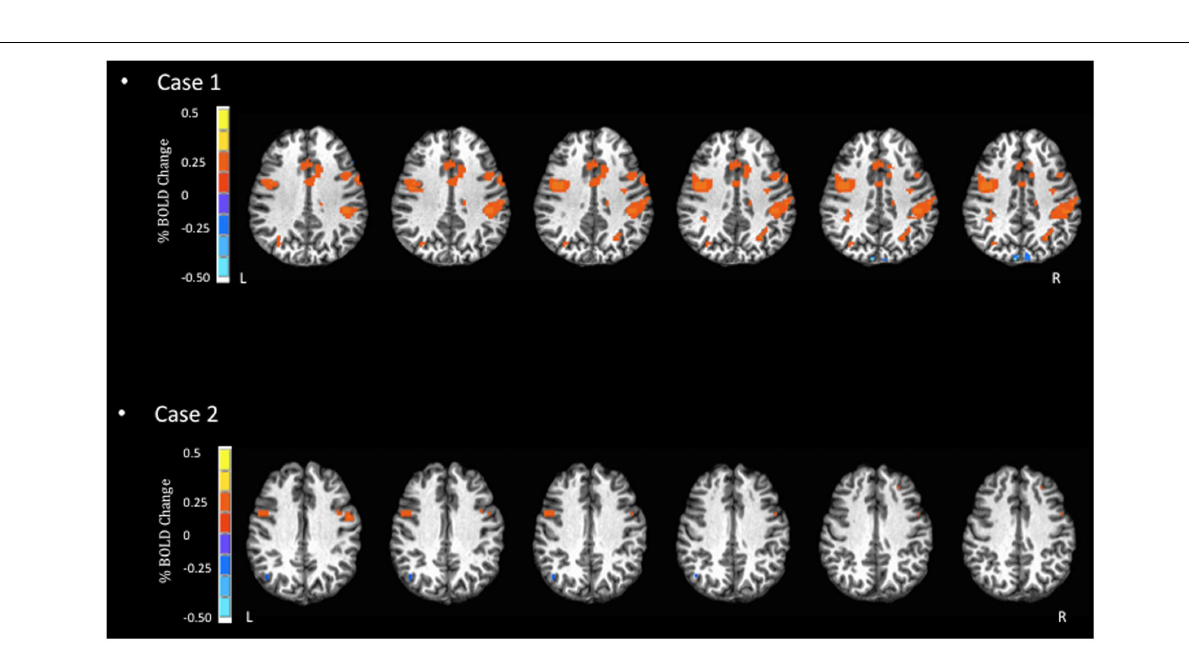
displayed distinctly different patterns of BOLD signal